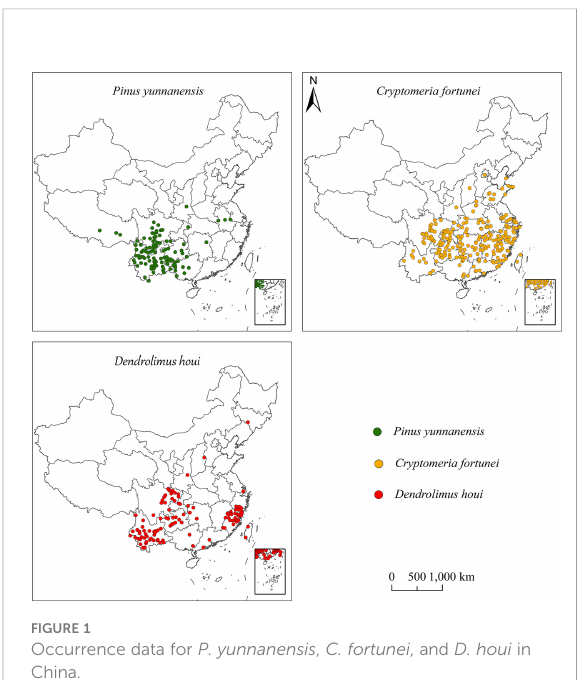
FIGURE 1 Occurrence data for P. yunnanensis , C. fortunei , and D. houi in